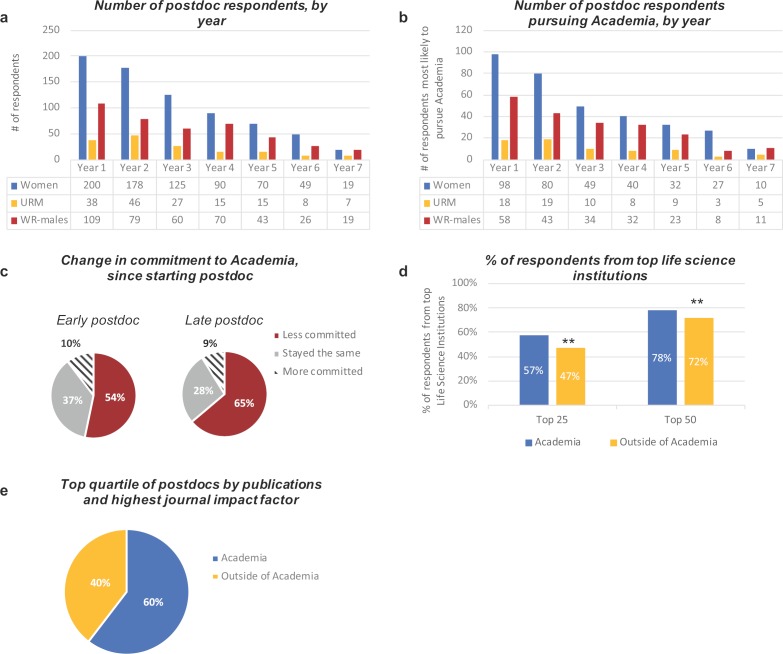
Characteristics of postdoc respondents.(a) Number of respondents in years 1 to 7 of their training for women (blue), underrepresented minority (yellow; URM), and well-represented male (red; WR-male) postdocs. (b) Number of respondents in years 1 to 7 of their training who are likely to pursue a research position in academia for women (blue), underrepresented minority (yellow; URM), and well-represented male (red; WR-male) postdocs. (c) Respondents were asked to indicate their change in commitment to each career path since starting as a postdoctoral researcher. The change in commitment to academia is shown for early and late postdocs who intend to most likely pursue a nonacademic career. (d) The percentage of academic-bound (blue) and nonacademic-bound (yellow) respondents from top US life science research institutions based on counts of high-quality research outputs from Nature’s Index data from January 1, 2017 to December 31, 2017. **p<0.001 (e) The career interests of respondents whose total publications were greater than or equal to 12 and highest journal impact factor was greater than or equal to 13, representing the top quartile of respondents.
Figure 1—figure supplement 1—source data 1.Source data on change in commitment to academia for nonacademic-bound postdocs.